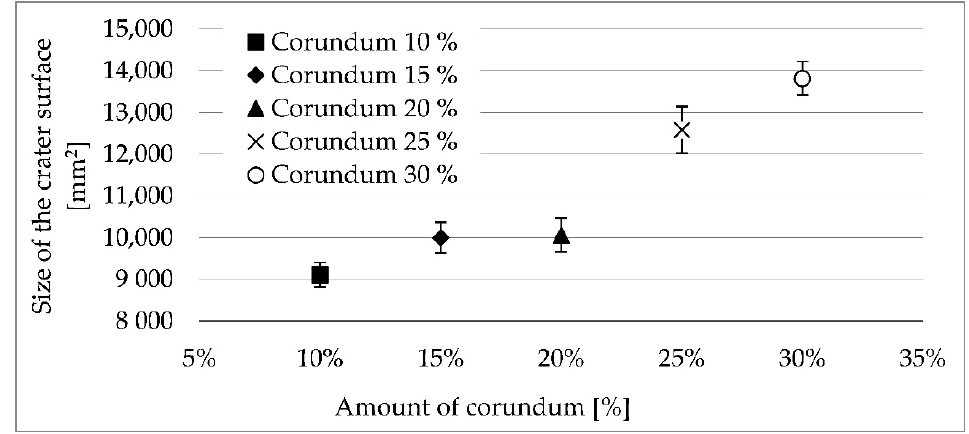
Figure 13. Size of the entrance crater area according to individual percentage substitutions.